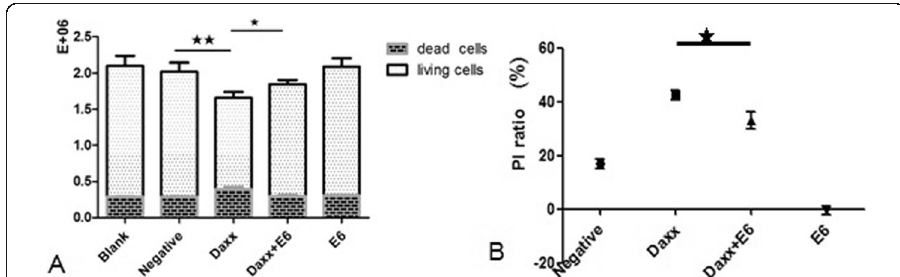
Fig. 3 Effects of HPV16 E6 on cell proliferation. a Cell count results for all groups. The cell counting unit was 10 6 , i.e., E+ 06. b Proliferation inhibition ratios for all groups. The proliferation inhibition (PI) ratio represents the inhibition of cell proliferation. ★ , p < 0.05; ★★ , p <